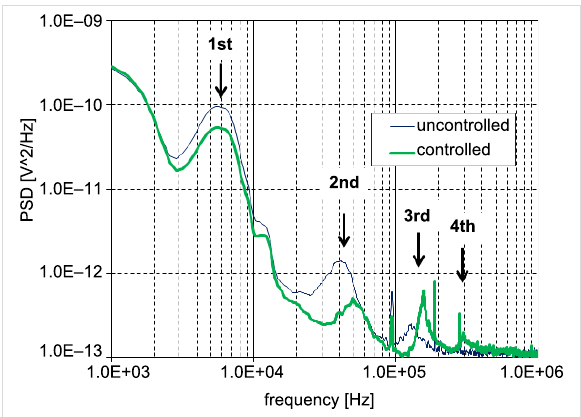
Figure 3b, a simple consideration of the transfer function reveals that the situation is effectively identical to the case of driving a virtual, resonance-free cantilever with the input wave- form [25]. The Q-control gain was fixed to this value through- out the measurement. Figure 4 shows a comparison of the power spectrum density (PSD) of thermal noise in the cantilever-deflection signal before and after Q-control gain opti- mization. The peaks in the noise density at the 1st and 2nd reso- nance modes are suppressed, whereas the peaks at the 3rd and 4th modes are enhanced as a result of the above-mentioned cutoff frequency, although this is not harmful for the measure- ment.